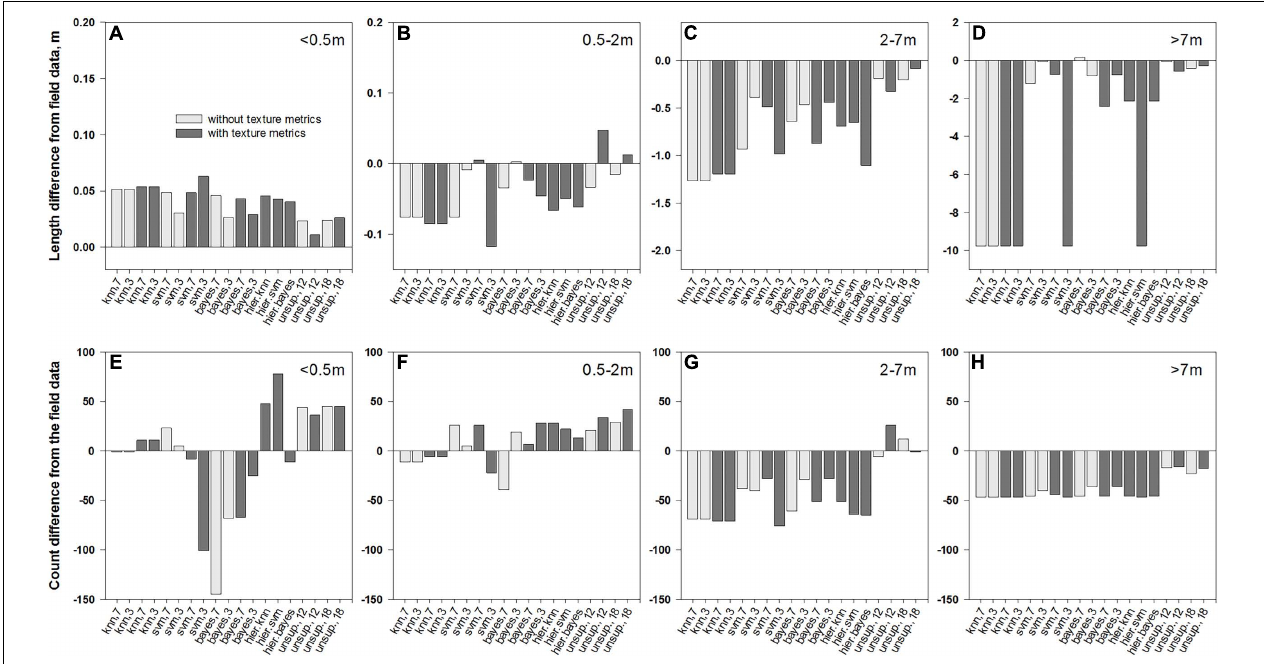
FIGURE 6 | Differences in average length of patch segments (A–D) and their counts (E–H) between field data and their intersections with medusahead classification outcomes summarized for different patch sizes: (A,E) < 0.5 m; (B,F) 0.5–2 m; (C,G) 2–7 m; and (D,H) > 7